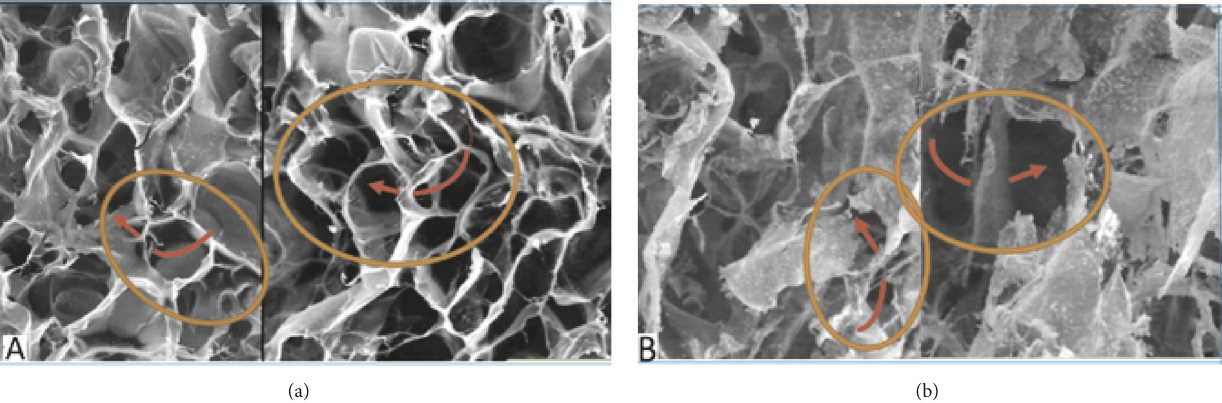
Figure 4: Pore interconnectivity in (a) SBCS group and (b) DSBCS group. Red arrow showed interconnectivity pore in area consisting of some pores within orange